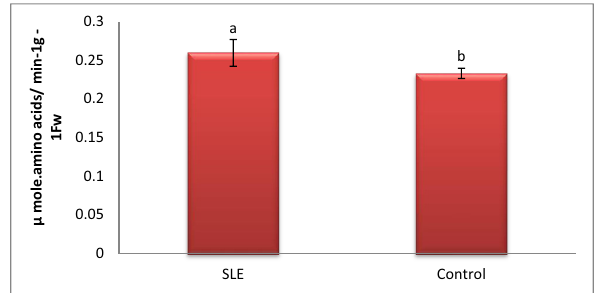
Figure 2: Protease activity of T. aestivum L. that treated with 2% SLE. The di ff erent letters are signi fi cant ( P ≤ 0.05 ) according to Duncan ’ s multiple range tests.